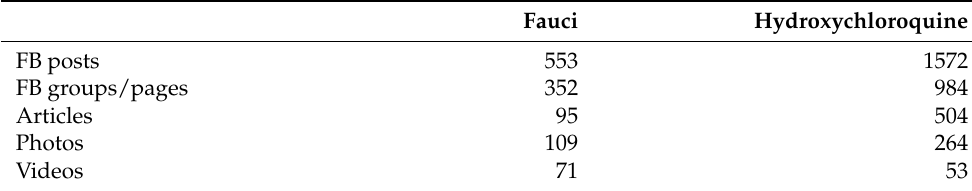
Table 6. Statistics for the collected COVID-19-related Facebook disinformation